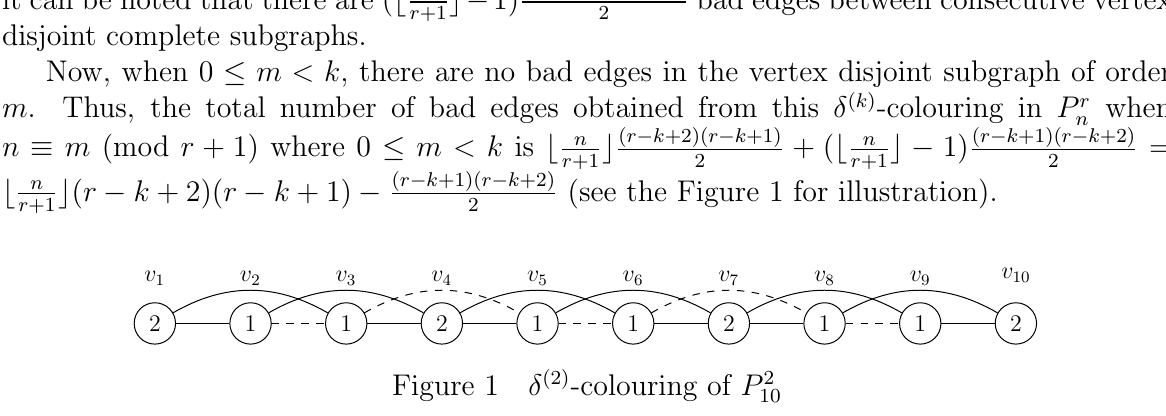
Figure 1 δ (2) -colouring of P 2